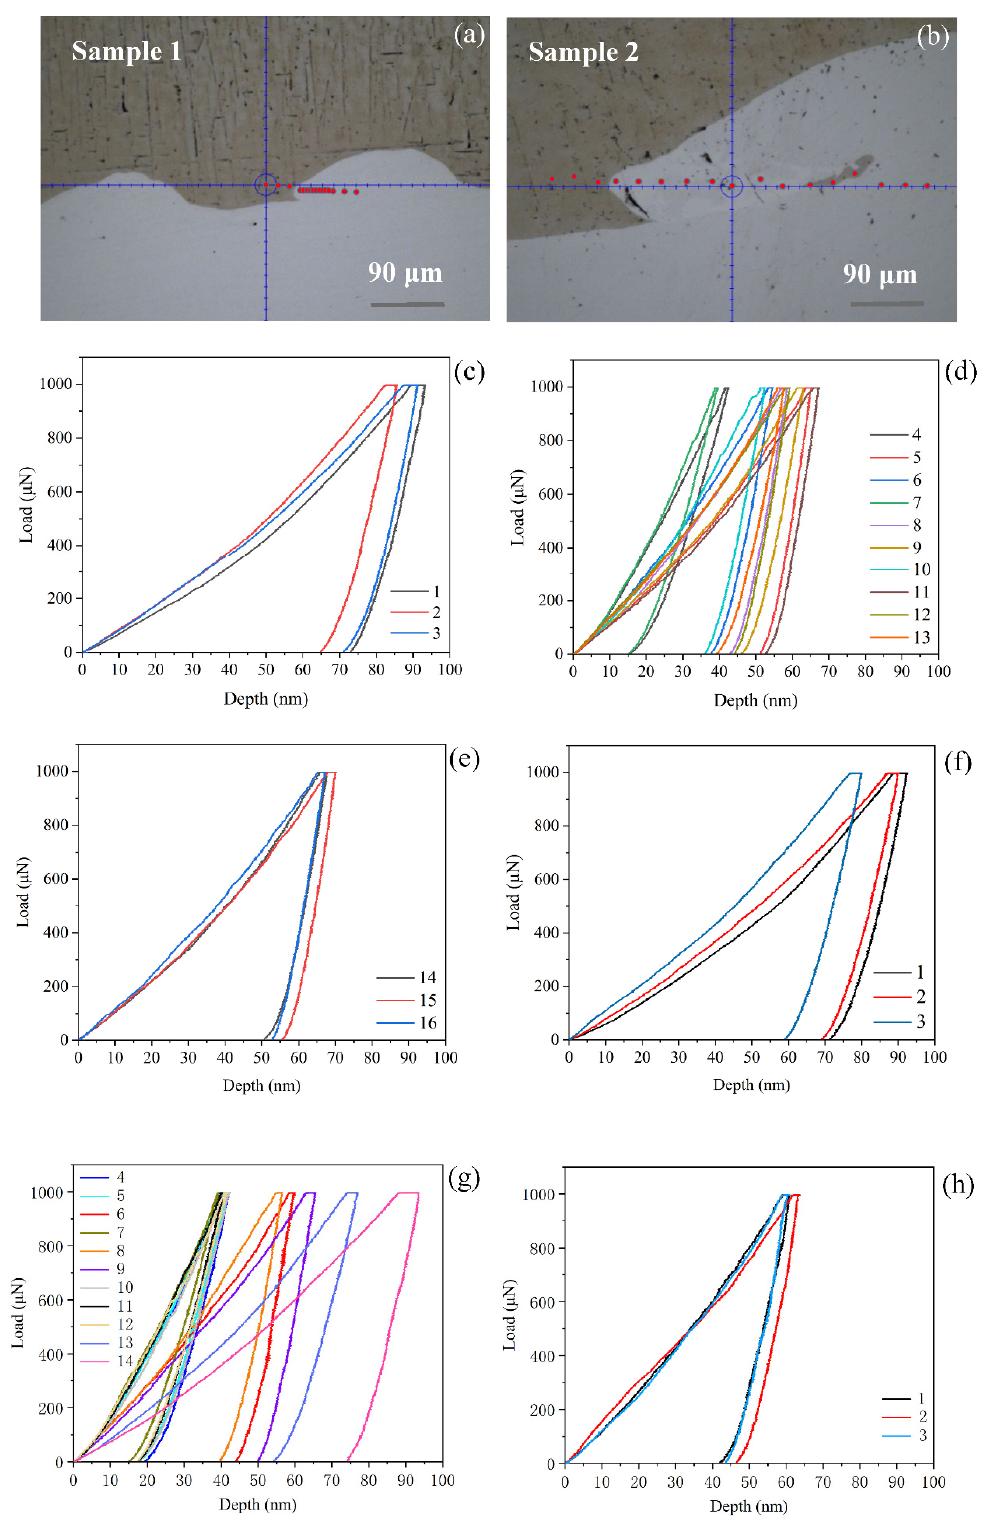
Figure 10. Nanoindentation test results: ( a ) stand-off = 5 mm; ( b ) stand-off = 15 mm; ( c ) load displacement curve Nos. 1–3 in Sample 1; ( d ) load displacement curve Nos. 4–13 in Sample 1; ( e ) load displacement curve Nos. 14–16 in Sample 1; ( f ) load displacement curve Nos. 1–3 in Sample 2; ( g ) load displacement curve Nos. 4–14 in Sample 2; ( h ) load displacement curve Nos. 15–17 in Sample